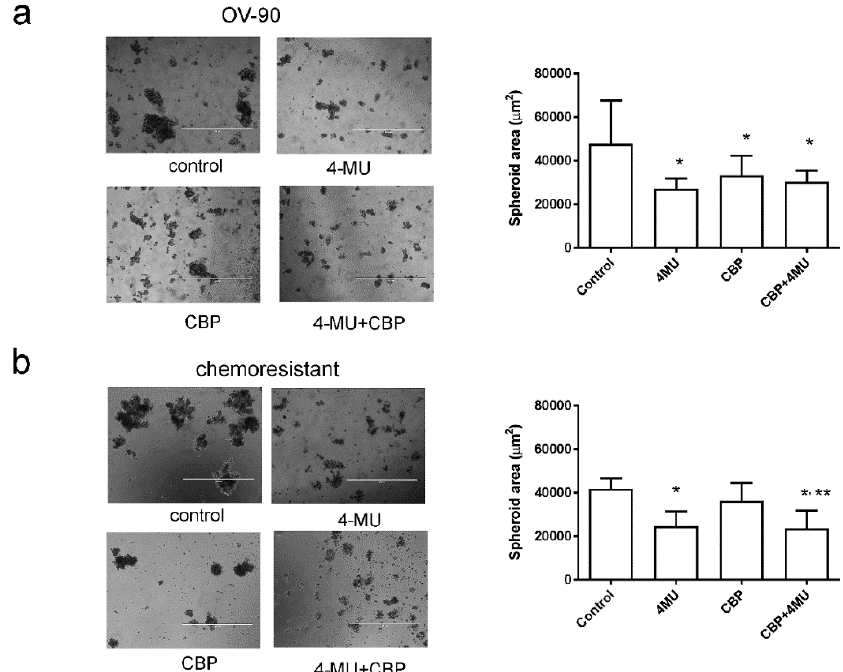
Figure 4. Effects of 4-methylubelliferone (4-MU) on spheroid formation. Representative images of spheroids formed by ( a ) OV-90 and ( b ) one of the chemoresistant primary ovarian cancer cells treated with control, 4-MU (1 mM), carboplatin (CBP, 100 µM), and 4-MU (1 mM) + CBP (100 µM) for 72 h. Data are expressed as median area of spheroids >200 µm in diameter (95% confidence interval, CI, n = 34–106) in five fields/treatment groups from 3–4 independent experiments. *, significantly different from control, **, significantly different from CBP treatment ( p <0.05, Kruskal–Wallis test, Dunn’s multiple comparison test). Scale bar = 1000 µm.